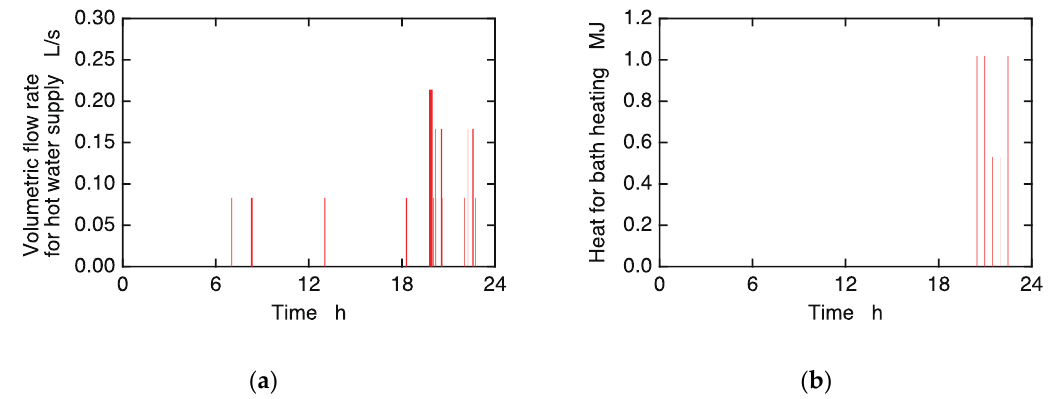
Figure 7. Hourly changes in hot water and bath heating demands: ( a ) general and bath hot water demands; ( b ) bath heating demand.